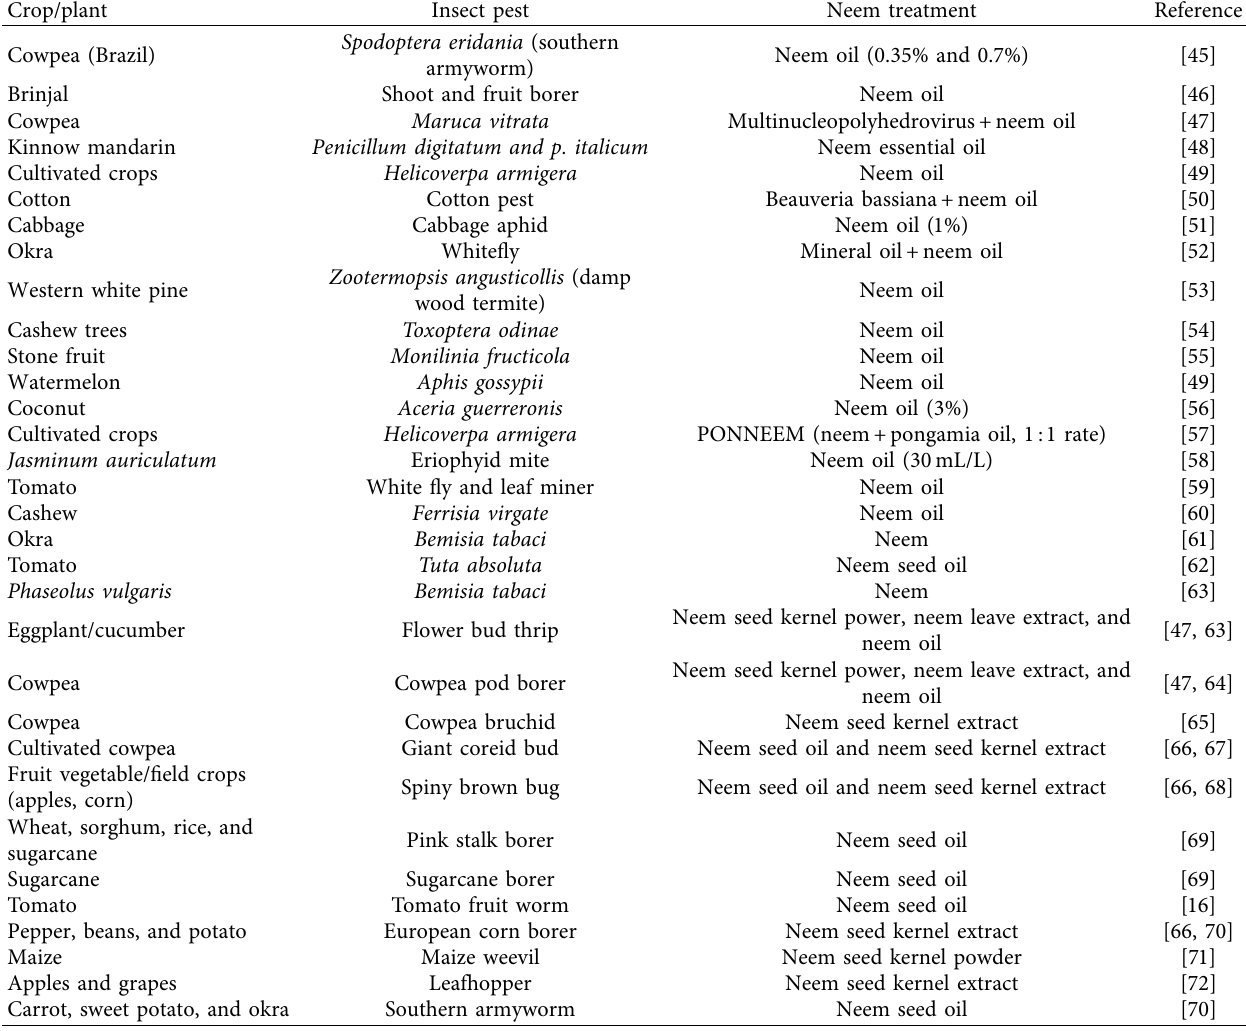
Table 3: Insect pests are controlled with neem treatments on a variety of